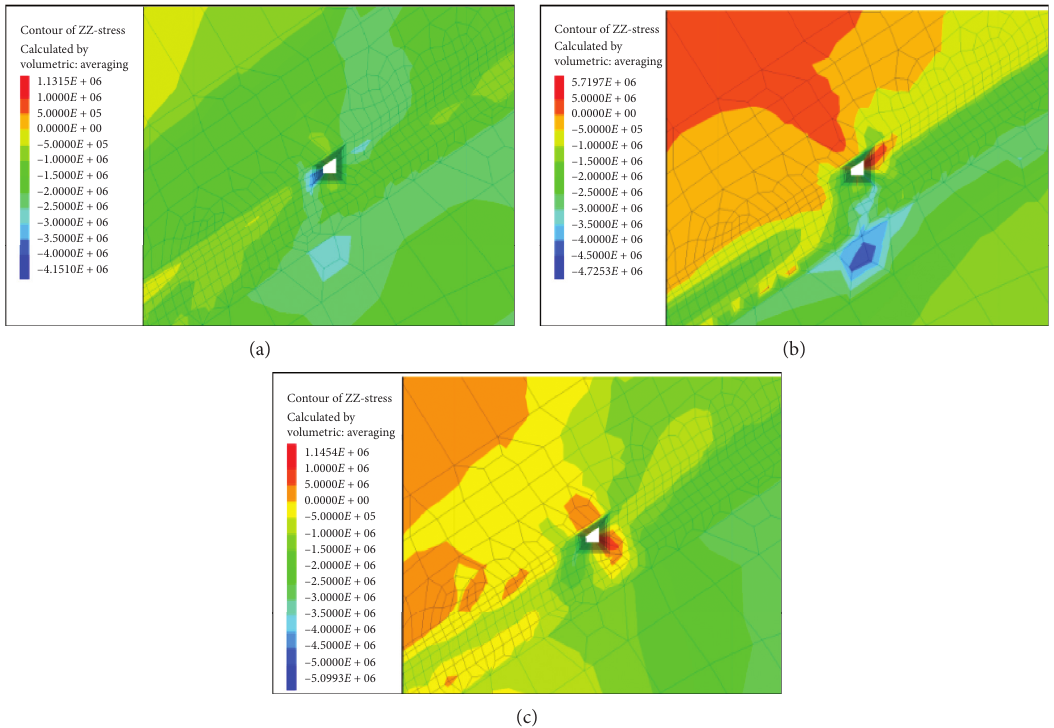
Contour of ZZ-stress Calculated by volumetric: averaging 1.1315 E + 06 1.0000 E + 06